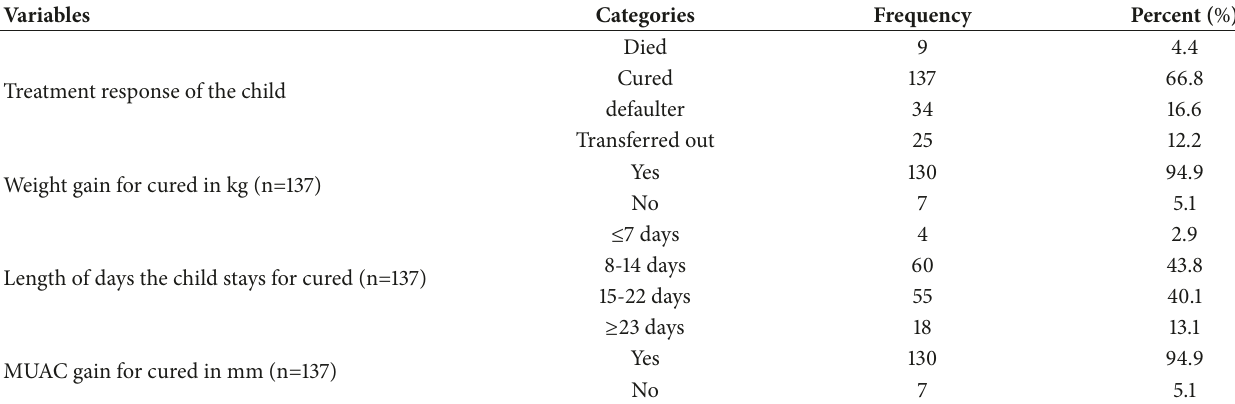
Table 4: Distribution of treatment outcome for SAM children who were admitted to NRH, West Ethiopia, from November 2015 to April 2017 (n=205).